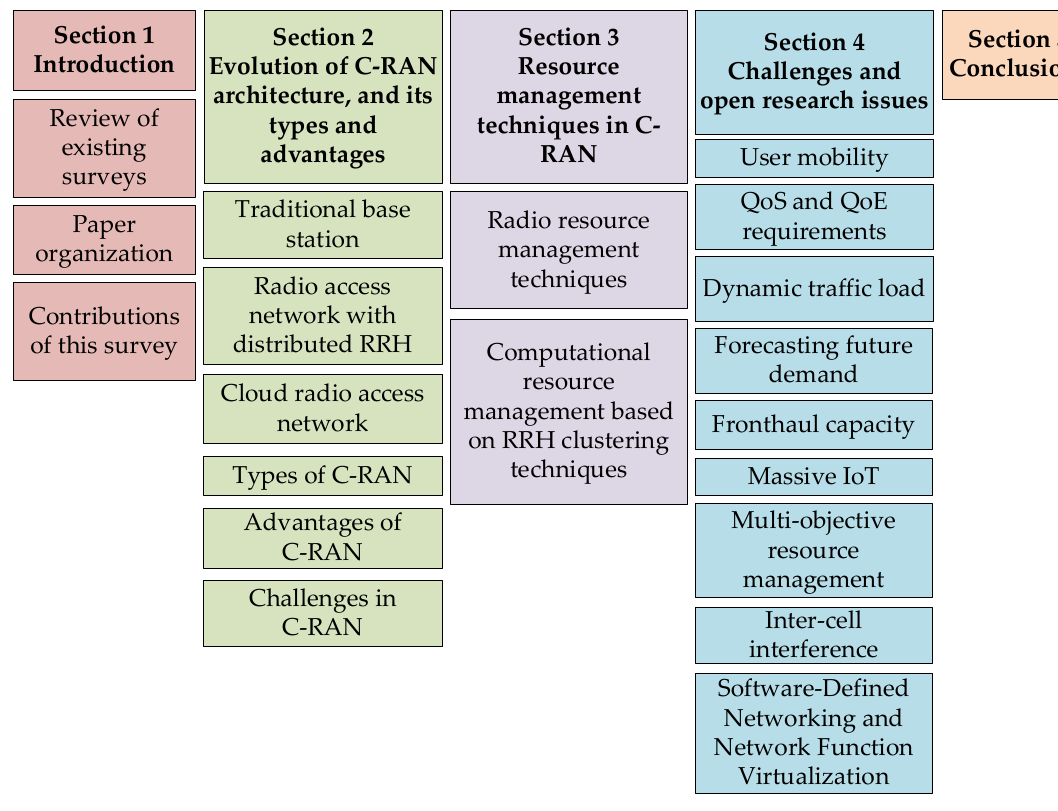
Figure 1. Organization of this survey.